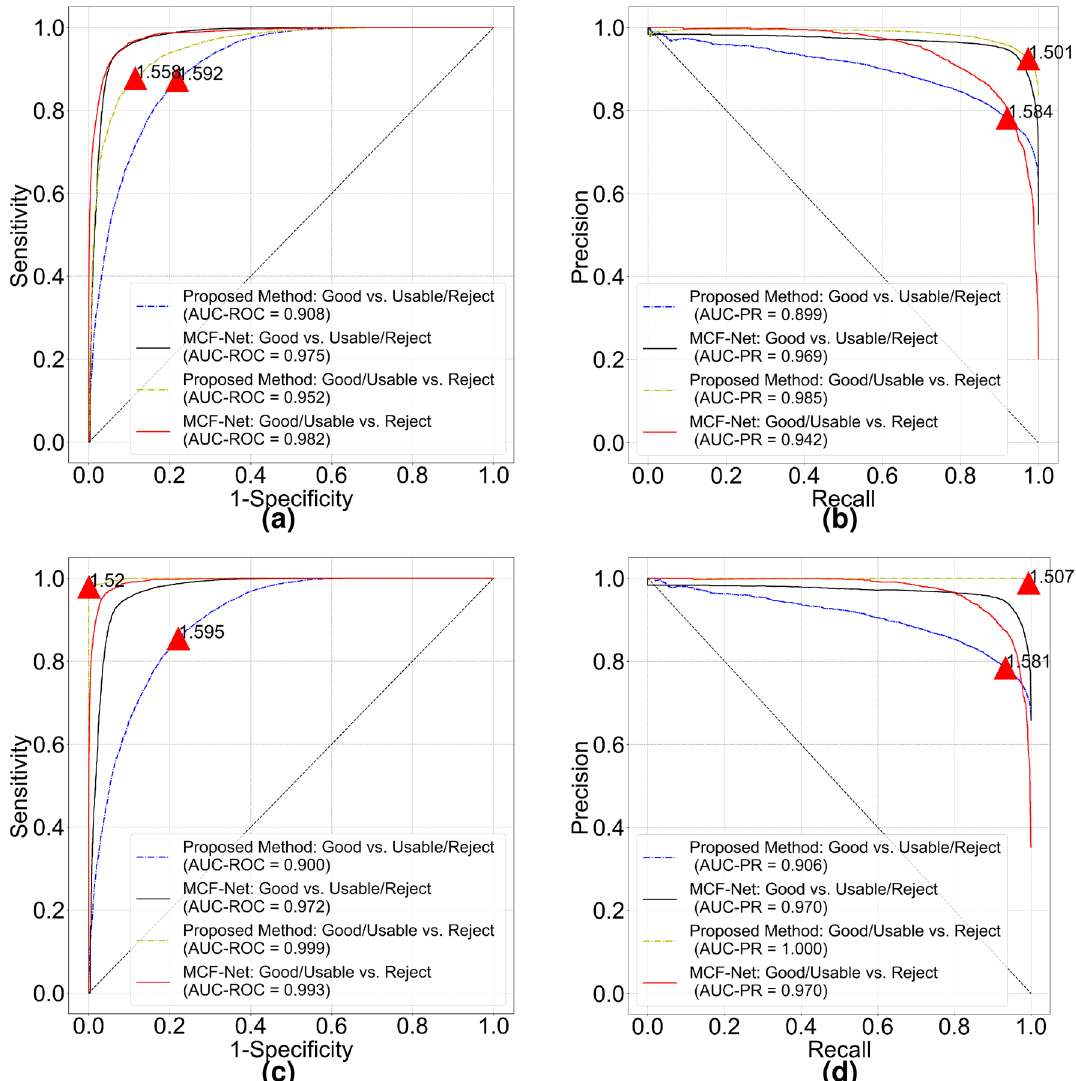
Figure 5. Performance comparison of the MCF-Net and proposed methods for classifying “Good” and “Reject” images in EyeQ test set. ( a ) ROC and ( b ) PR curves are measured on the original labels from human graders. We show revised ROC and PR curves in ( c , d ) to indicate classification performance after removing potential incorrect labels. Red triangle and numerical digit on each curve indicate the optimal cut off point and FD threshold of the proposed method.